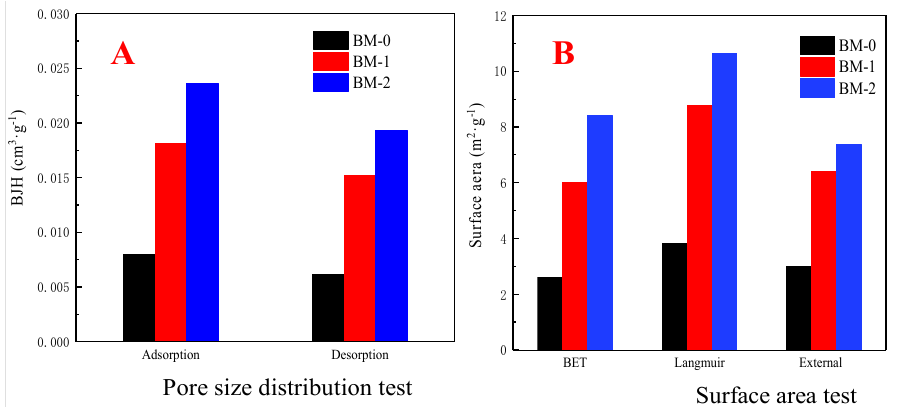
Figure 4. Charts of the porous media analysis. ( A ) Pore size distribution test; ( B ) Surface area test.